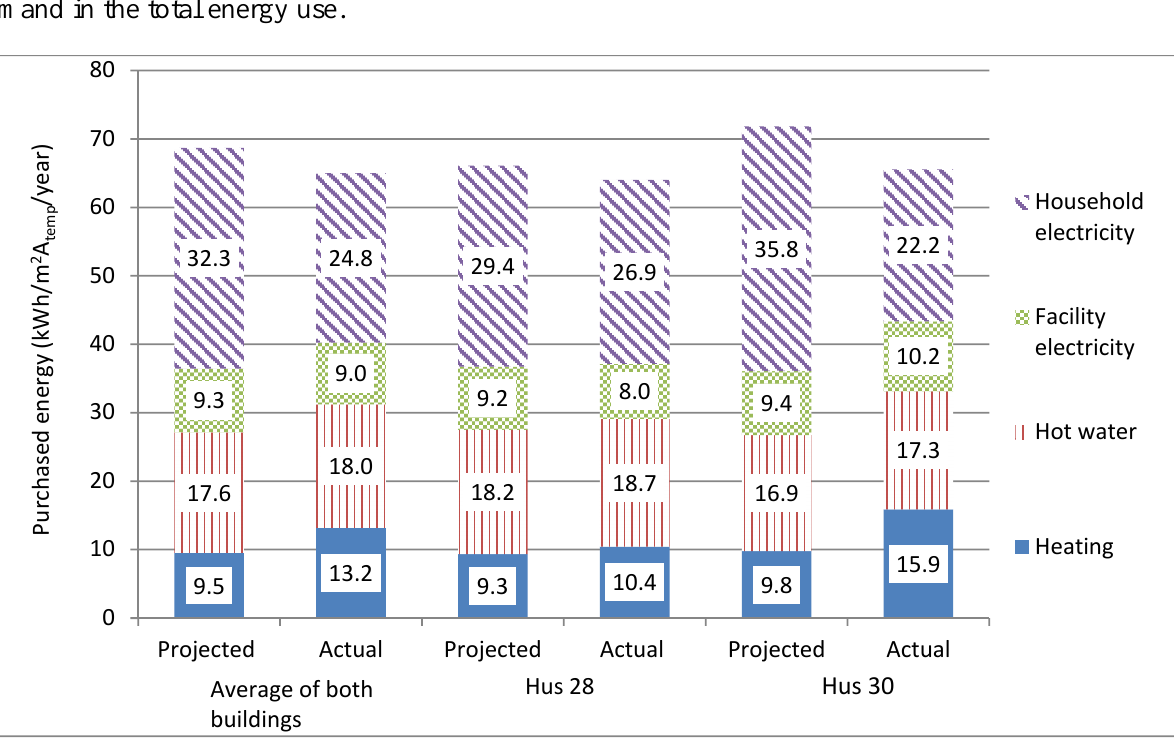
Figure 2. Projected (revised from [7]) and actual energy use in 2012 of the Portvakten Söder buildings. Energy use for heating is